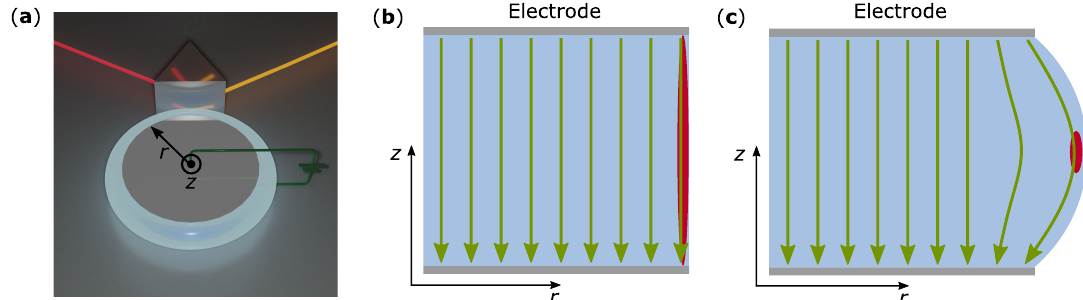
Figure 1. ( a ) Artist drawing of a setup used in recent experiments of frequency conversion schemes involving bulk lithium niobate whispering gallery resonators involving the electro-optic effect. The laser light is coupled into the WGR via a coupling prism. The resonator is coated with a metal electrode. ( b , c ) The electric field distribution indicated by the green lines for a cylindrical resonator with an idealized homogeneous field and for a commonly used resonator geometry. The red area indicates the size and position of the optical mode, not to